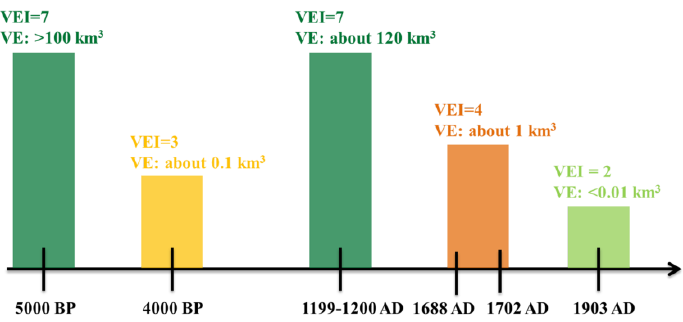
Figure 1. The number of eruptions, volume of eruption (VE) and volcanic explosive index (VEI) of Tianchi volcano.